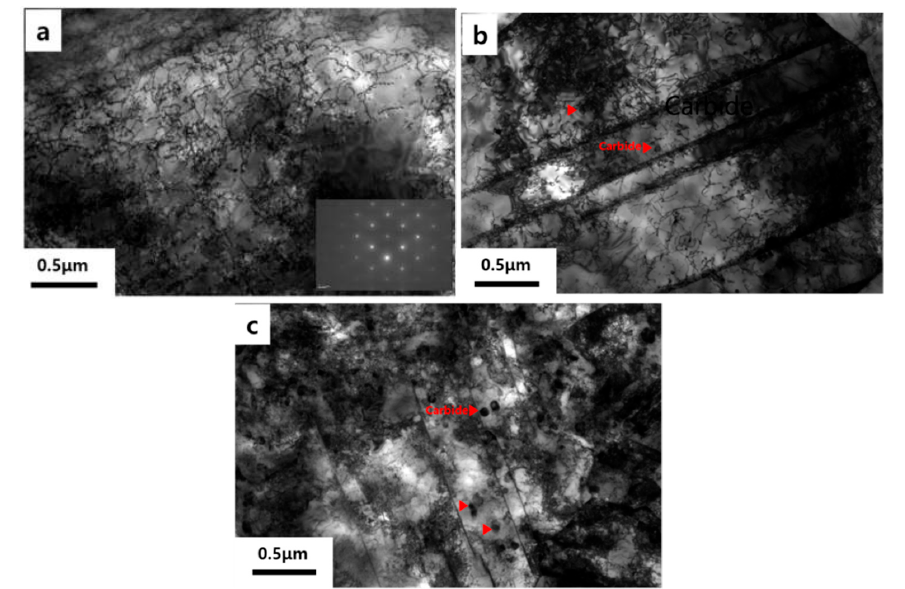
Figure 8. TEM microstructures of (NiCo) 75 Cr 17 Fe 8 ( a ), (NiCo) 75 Cr 17 Fe 8 C 0.34 ( b ) and (NiCo) 75 Cr 17 Fe 8 C 0.83 ( c ) deformed to 20% at room temperature.